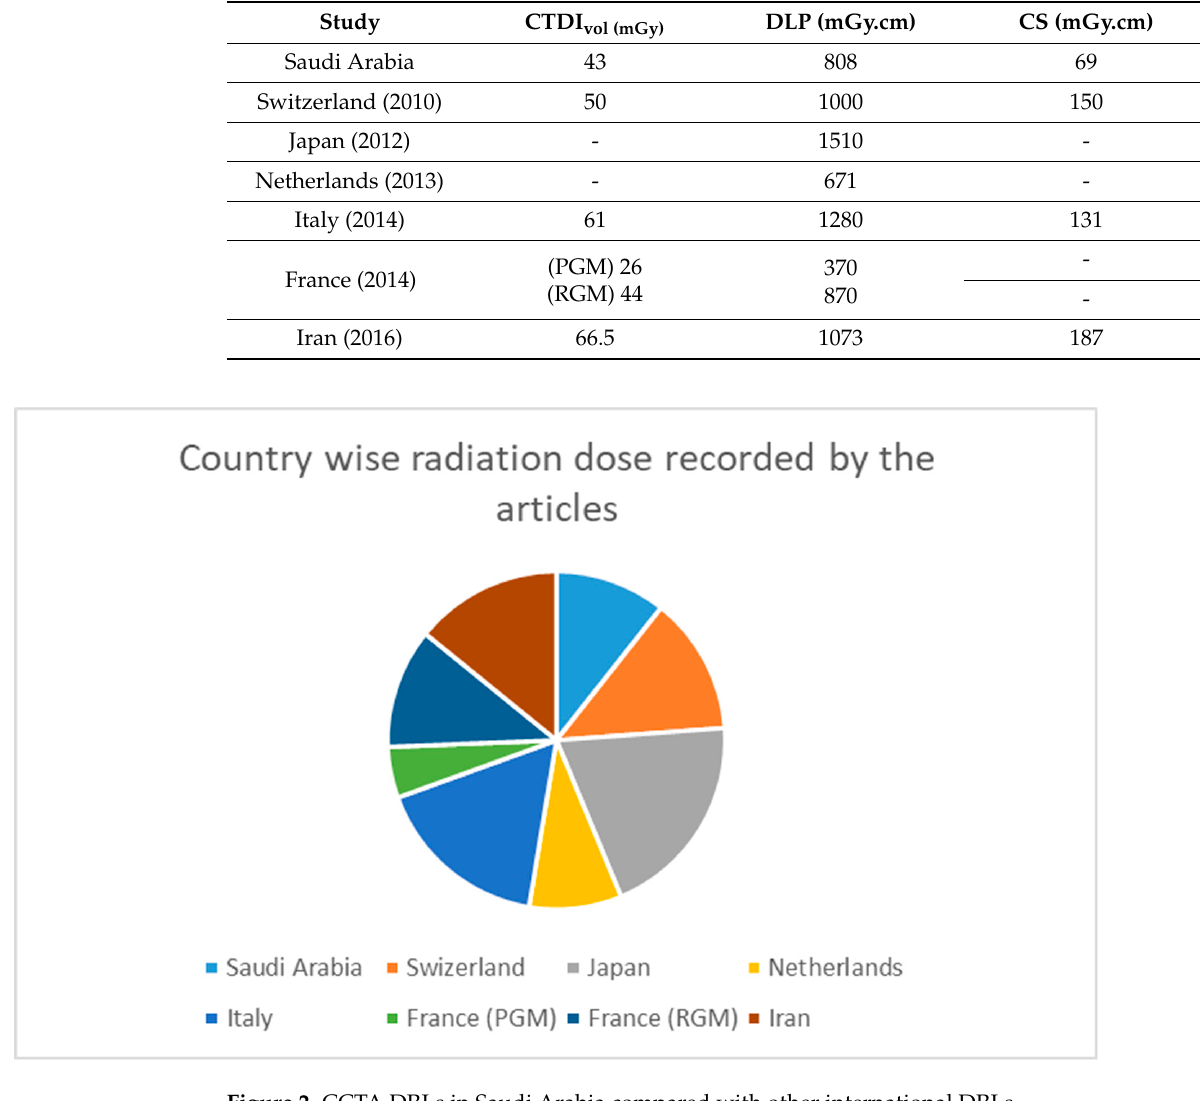
Figure 2. CCTA DRLs in Saudi Arabia compared with other international